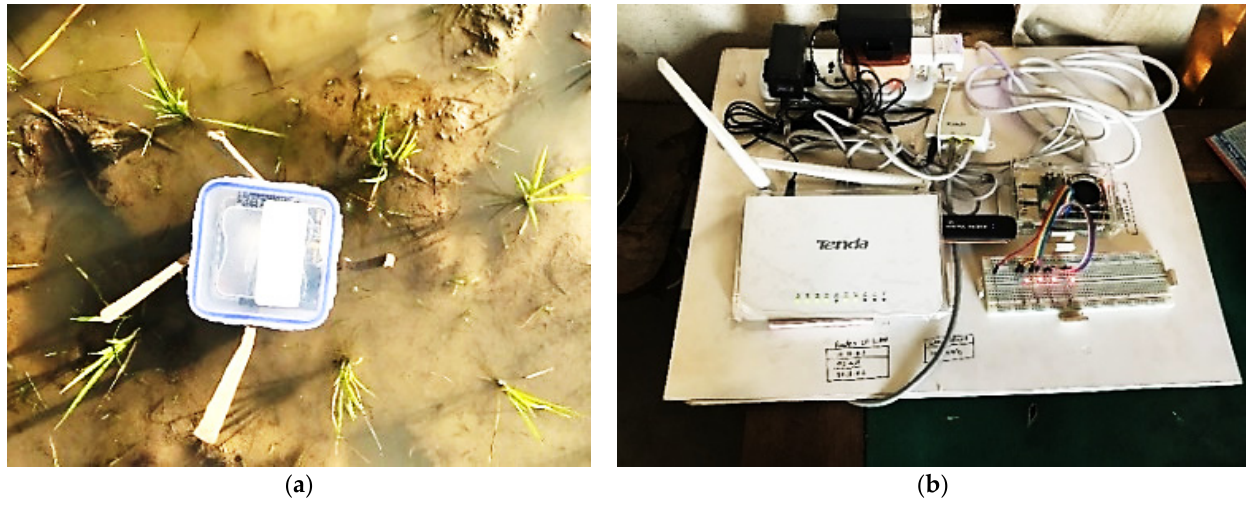
Figure 11. Agricultural field level trial setup: ( a ) Top view of a sensor device in the field ( b ) The receiver base station setup.